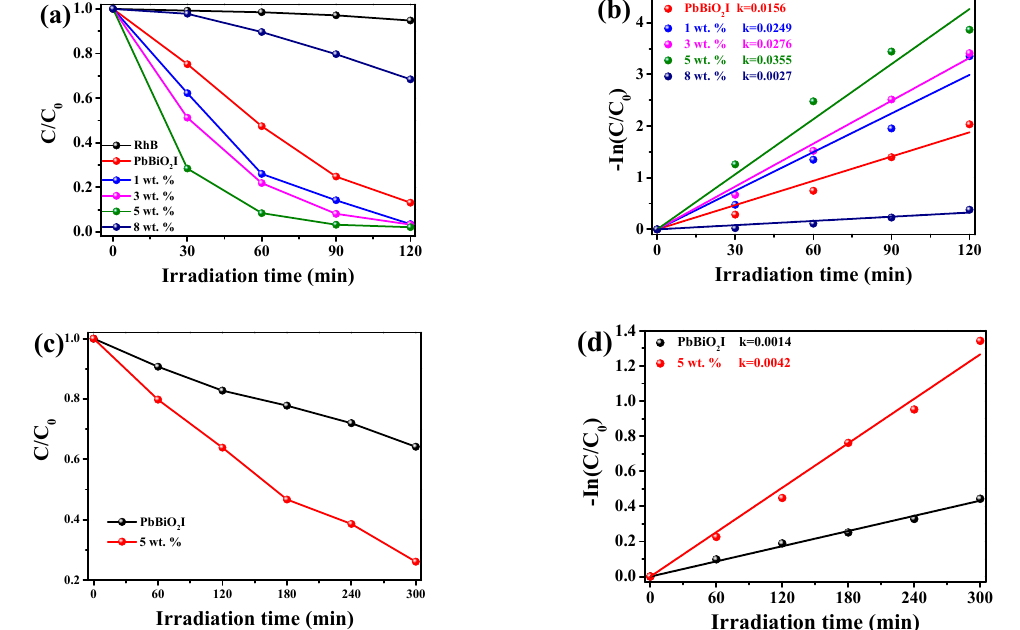
Figure 3. Photocatalytic properties of the catalysts for the degradation of RhB ( a ) and CIP ( c ) under visible light irradiation ( λ > 400 nm); reaction kinetics for the degradation of RhB ( b ) and CIP ( d ) under the same condition.